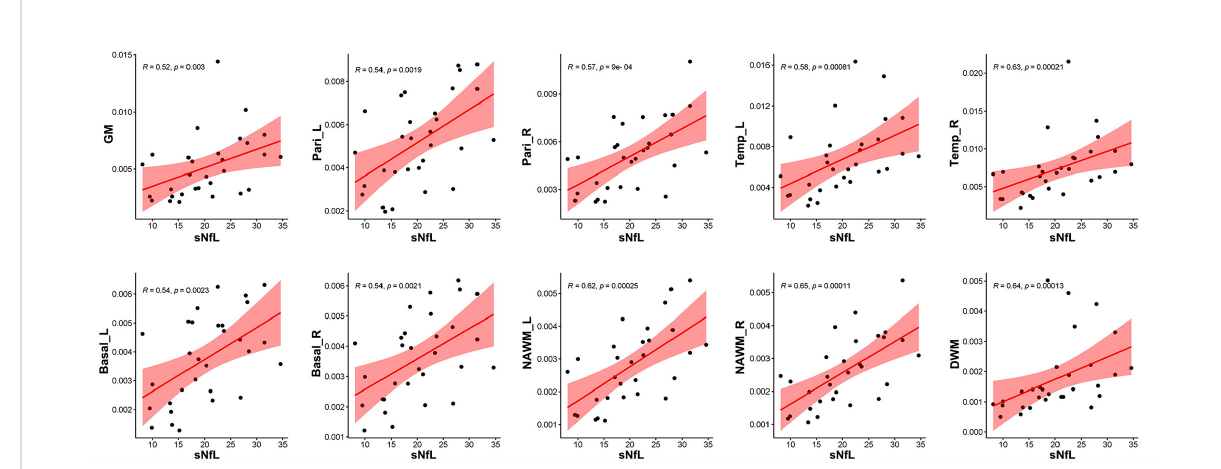
FIGURE 8 Correlation between sNfL and CBF in different regions. CBF values in global GM ( R = 0.52, p = 0.0030), bilateral parietal lobes (left: R = 0.54, p = 0.0019, right: R = 0.57, p = 0.0009), bilateral temporal lobes (left: R = 0.58, p = 0.00081, right: R = 0.63, p = 0.00021), bilateral basal ganglia (left: R = 0.54, p = 0.0023, right: R = 0.54, p = 0.0021), NAWM (left: R = 0.62, p = 0.00025, right: R = 0.65, p = 0.00011), and DWM ( R = 0.64, p = 0.00013) were positively related to